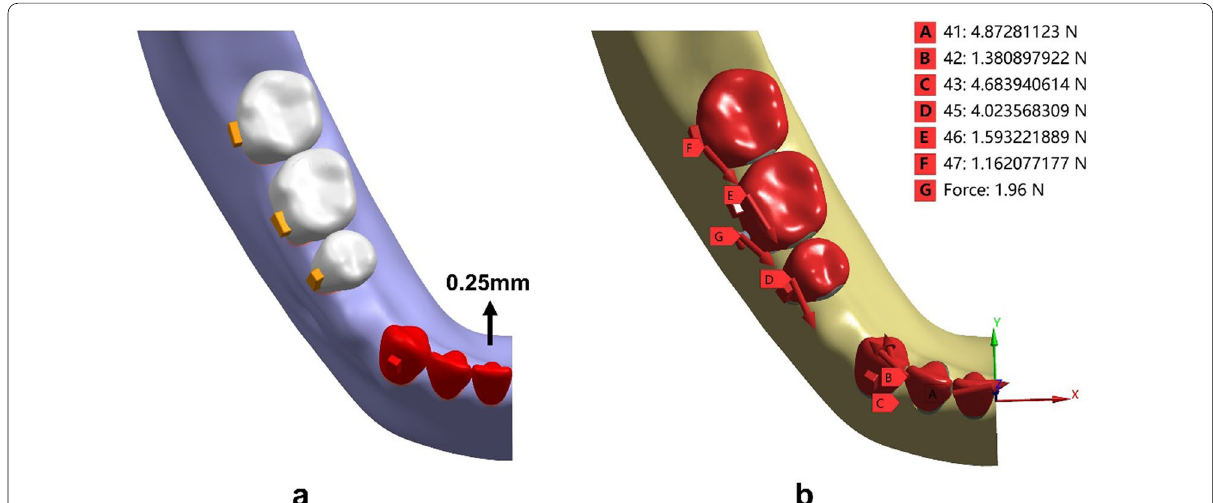
Fig. 4 Loading method to simulate anterior en-masse retraction. a The displacement load was applied to the aligner by 0.25-mm lingual movement of the incisors and canine along the occlusal plane. b The upper right corner showed the force value of each tooth. A-H represented the forces exerted on the central incisor, the second incisor, the canine, the second premolar, the first molar and the second molar,